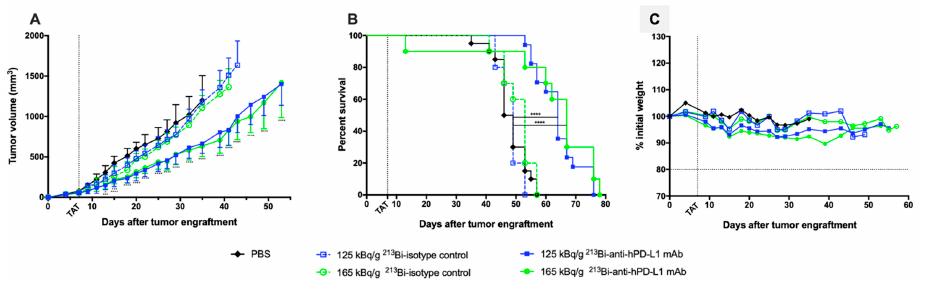
Figure 4. Targeted alpha-particle therapy (TAT) efficacy using 213 Bi-anti-hPD-L1 mAb in M113 PD-L1+ melanoma xenograft